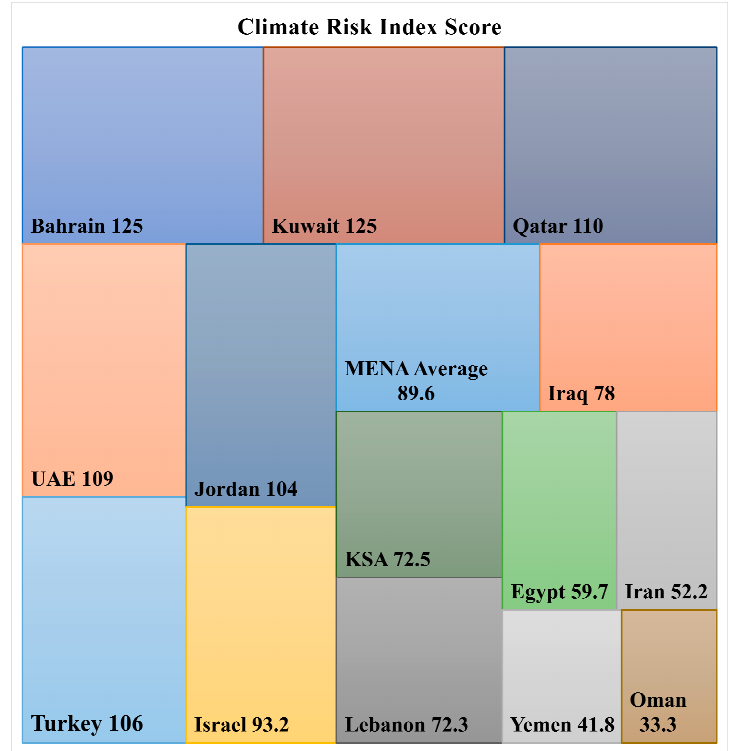
Figure 6 . Climate Risk Index Score in the Middle East in 2015. The index is a weighted score calculated according according to the following setting: Number of Deaths (weight: 1 / 6), Deaths per 100,000 inhabitants to the following setting: Number of Deaths (weight: 1/6), Deaths per 100,000 inhabitants (weight: 1/3), losses in (weight: 1 / 3), losses in Purchasing Power Party (PPP) (weight: 1 / 6), and Losses per GDP unit (weight: Purchasing Power Party (PPP) (weight: 1/6), and Losses per GDP unit (weight: 1/3). Lower score indicates a 1 / 3). Lower score indicates a country being more at risk to climate change events. The data is acquired country being more at risk to climate change events. The data is acquired from: https://idea.usaid.gov. from: https: //